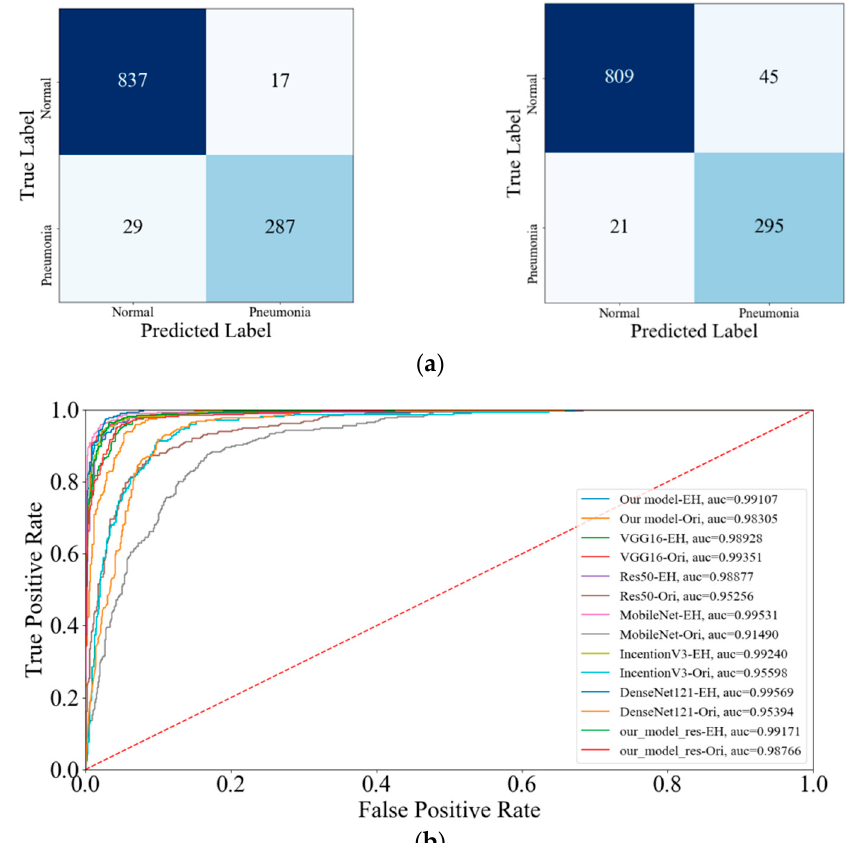
Figure 7. Confusion matrix and ROC curve of model. ( a ) The confusion matrix of model; ( b ) the ROC curve and AUC value of different models where Ori denotes the model using original images and EH denotes the model using enhanced images.